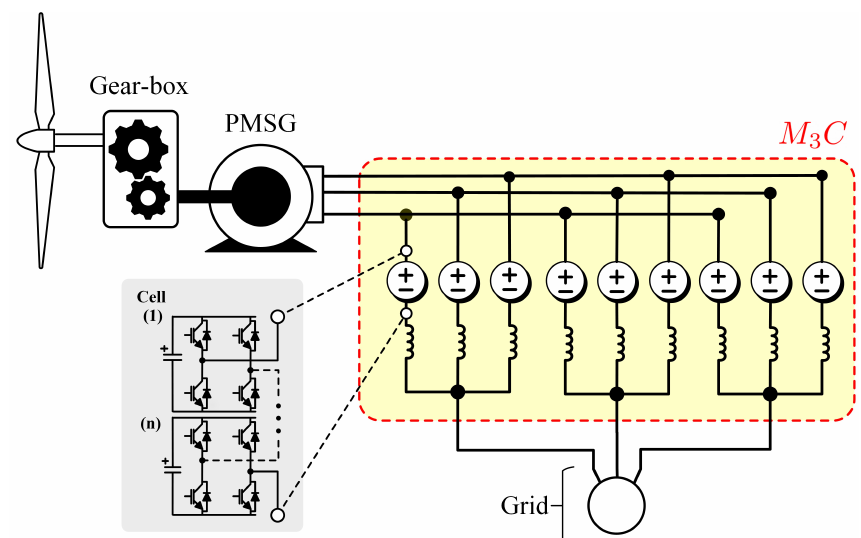
Figure 7. Implementation of a wind energy conversion system based on a Permanent Magnet Synchronous Generator (PMSG) and an M 3 C . Adapted from